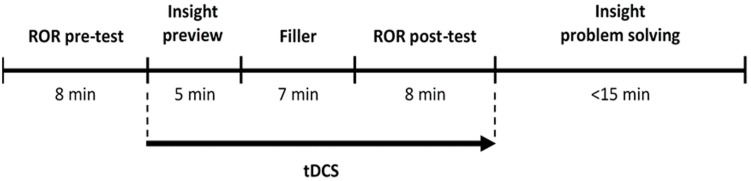
Experimental procedure. The arrow indicates the period during which (sham or active) tDCS was applied.